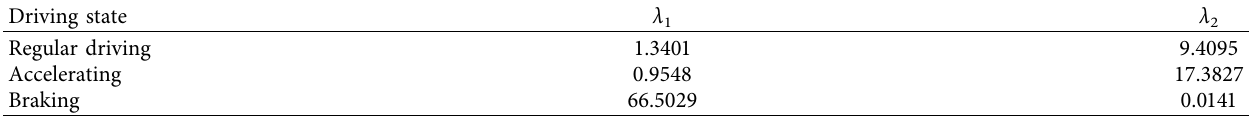
Table 2: Result of parameter calibration of M-MD